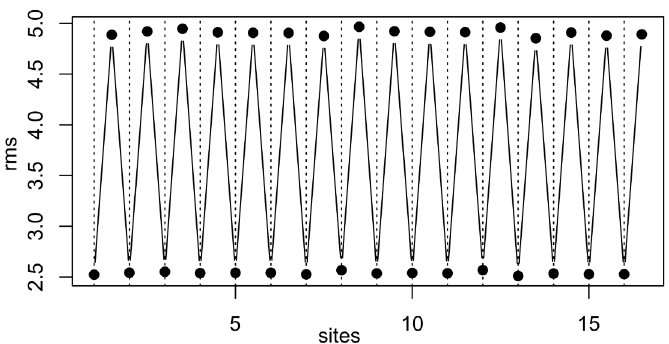
Figure 5 . Contributions to Im( S ) for the contour corresponding to the ansatz with no special point. The rms values at the (integer) lattice sites is now non-zero, although it is still smaller than the contributions from nearest neighbour pairs (“half-integer lattice sites”).